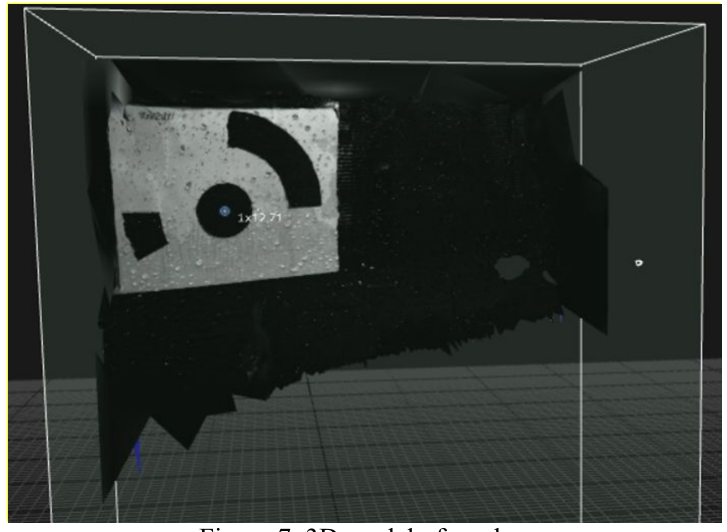
Figure 7. 3D model of marker